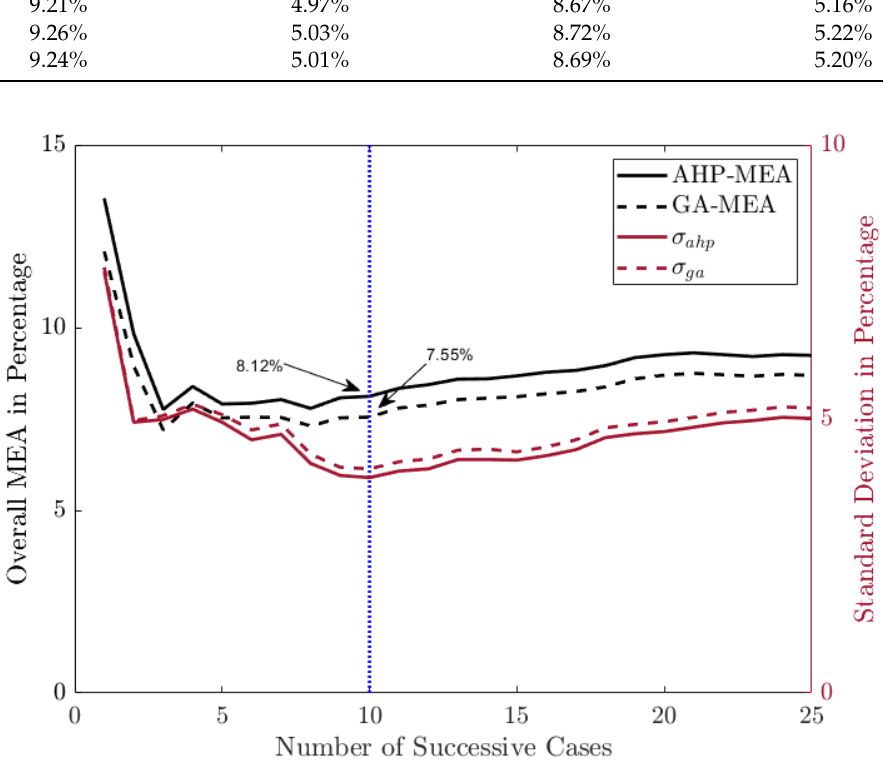
Figure 6. Steps followed in CBR [59] .